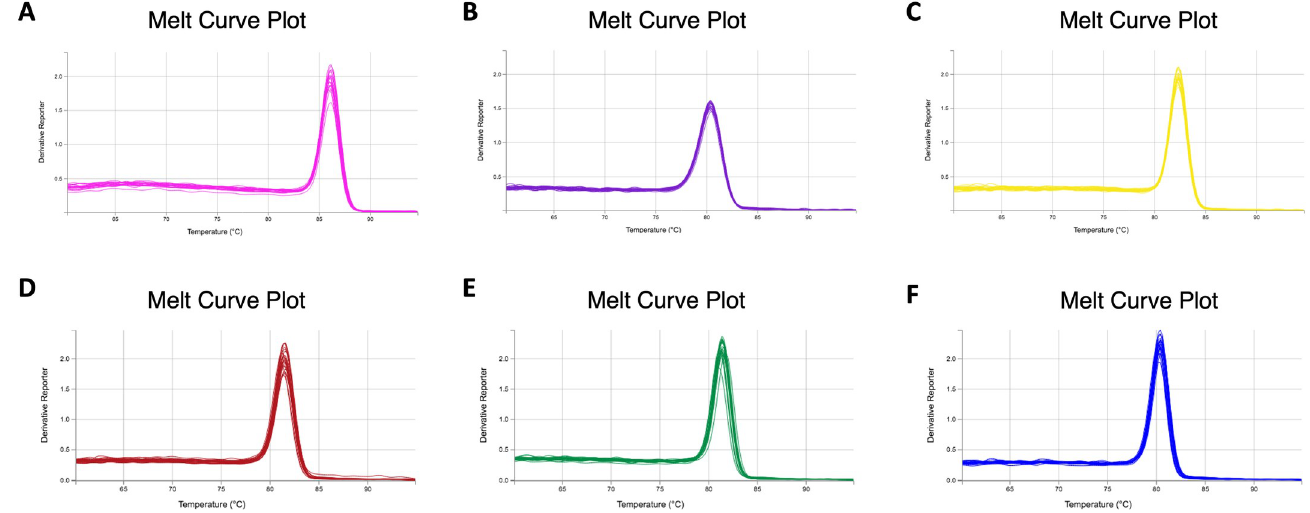
Fig 2. Melting curves of the primers for the candidate genes. A) ACTB . B) B2M . C) PGAM-1 . D) GAPDH . E) HPRT . F) PPIA